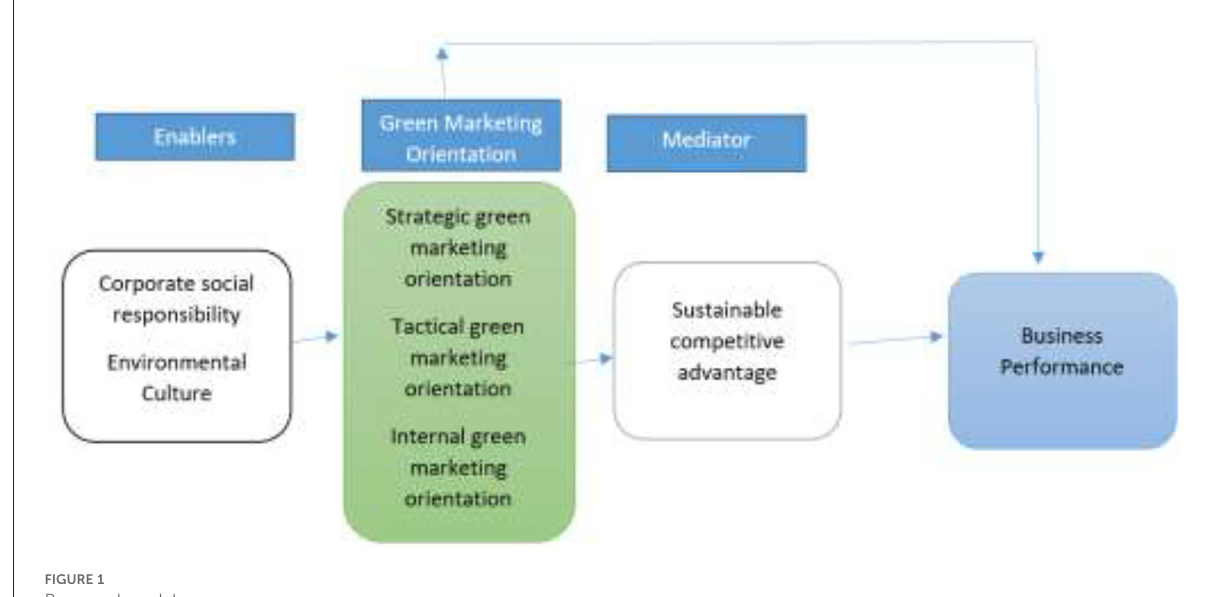
FIGURE1 Proposed